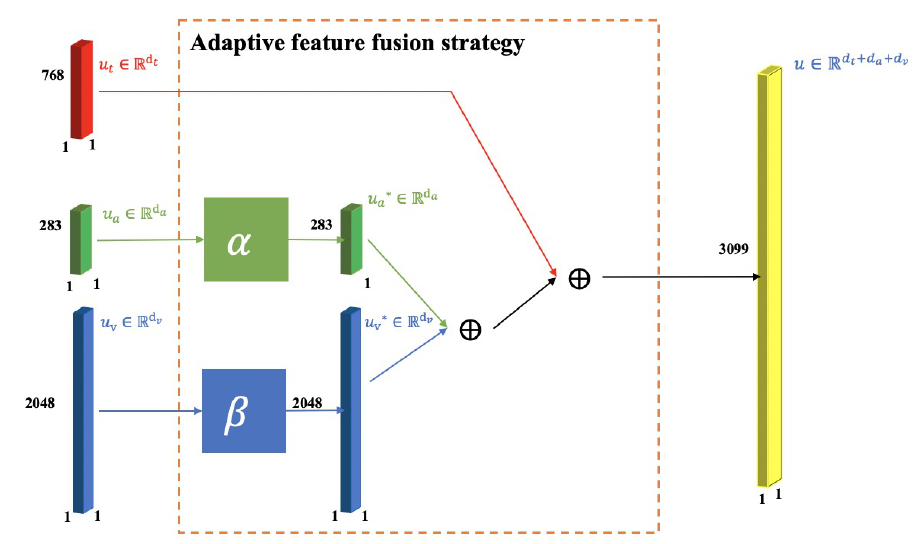
Figure 4. Adaptive feature fusion strategy diagram. Where α and β are the parameters of the subnetworks ϕ ( · ; α ) and φ ( · ; β ) , ⊕ represents the join operation, and u ∗ a and u ∗ v are the subnetworks ϕ ( · ; α ) and φ ( · ; β ) output.